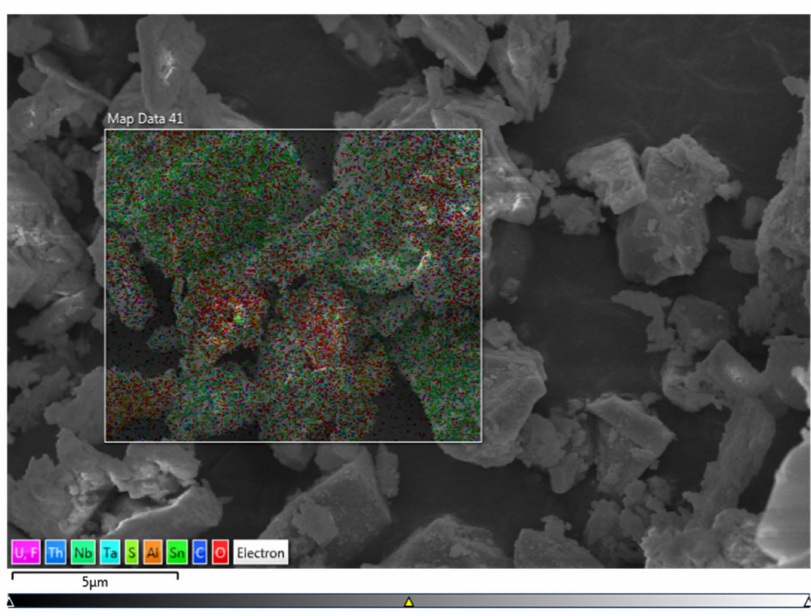
Figure 2. EDS image of tantalum-niobium slag. Figure 1 was the SEM image of the tantalum-niobium slag at 2000 × . It showed